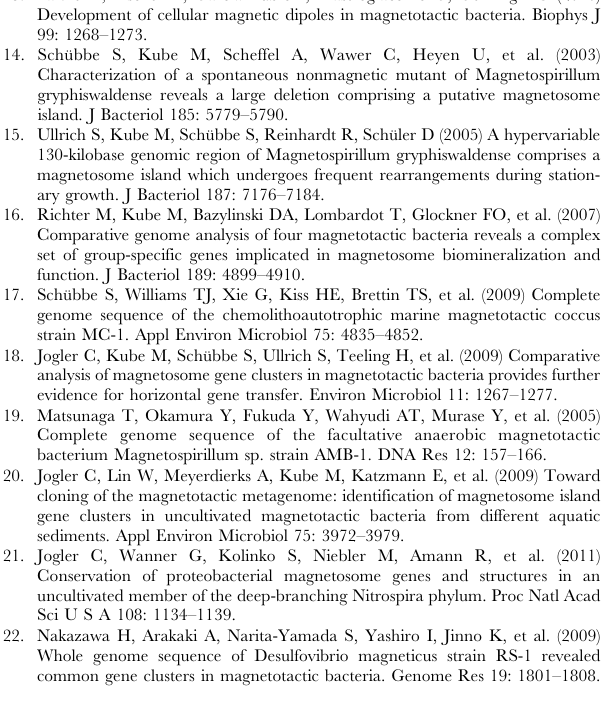
Table S1 Strains and plasmids used in this study. Table S2 DNA oligonucleotides used in this work. Table S3 Annotation and characteristics of MAI genes of